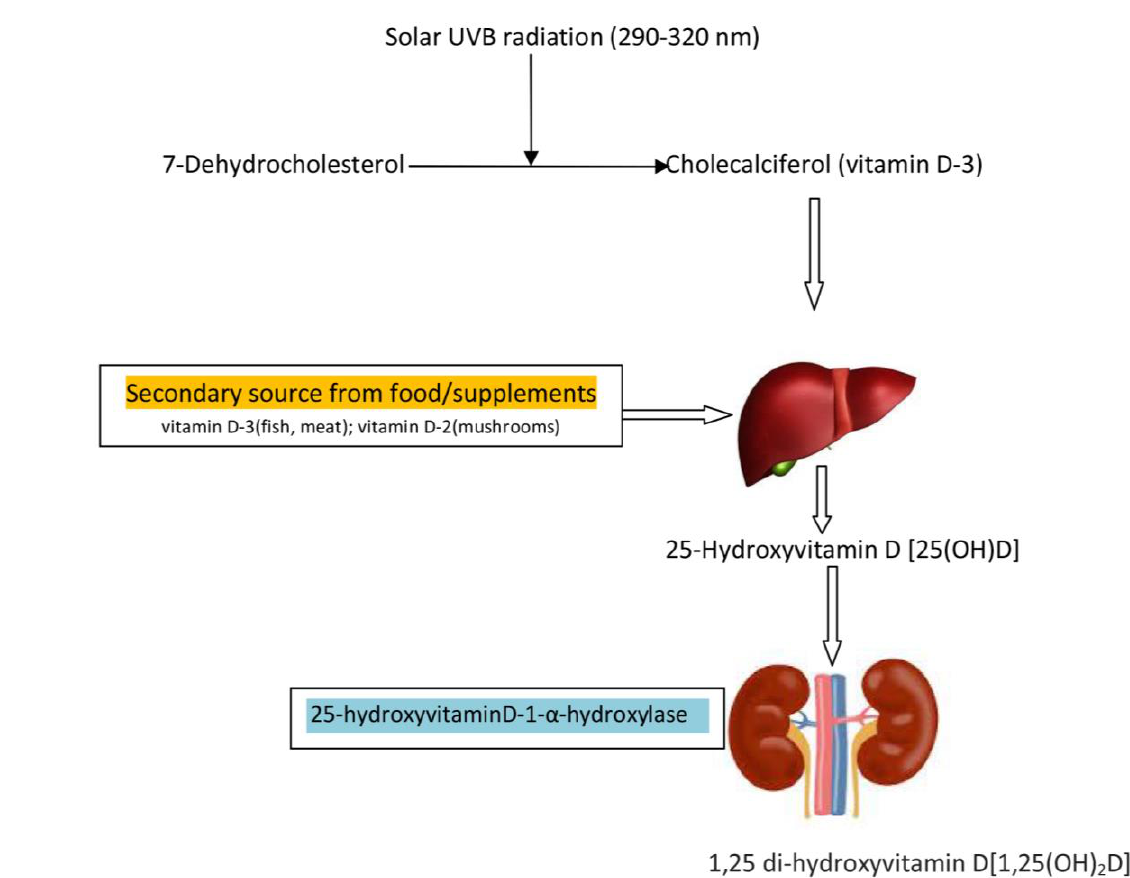
Figure 1. Skin—Principal Source of Vitamin D